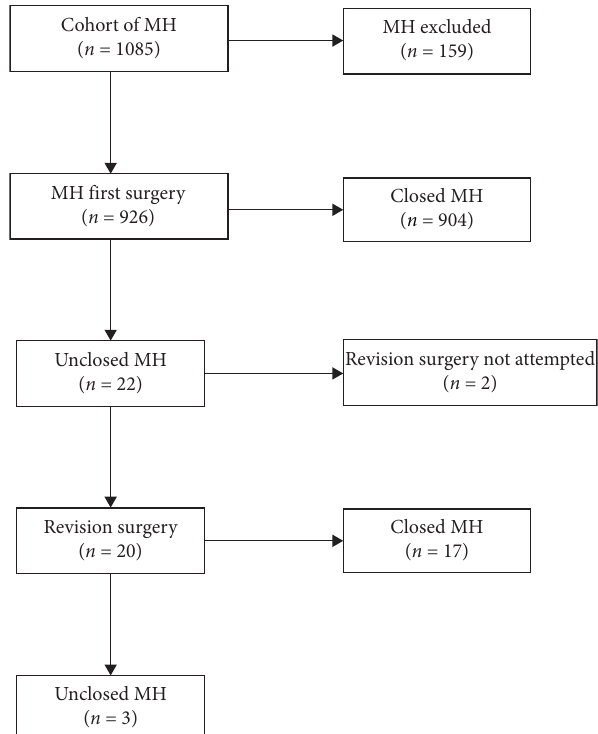
Figure 1: Flow chart showing the management process of eyes undergoing primary and revision surgery. MH: macular